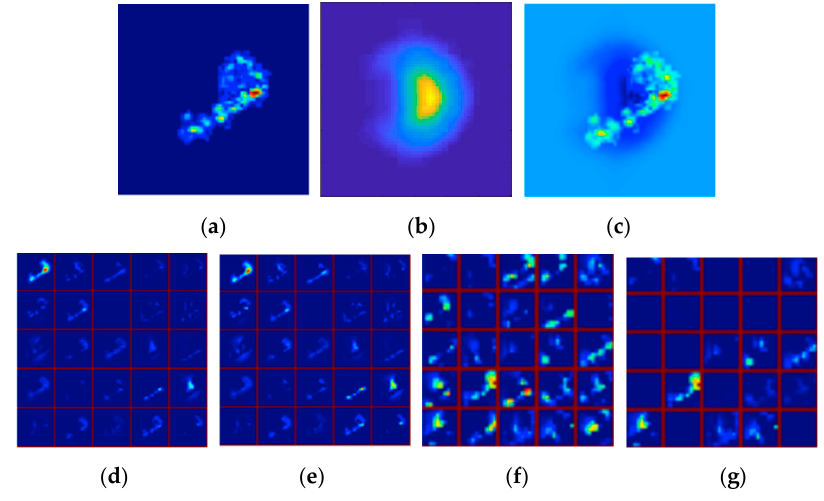
Figure 10. Visualization of feature maps in the ESENet. ( a ) input image; ( b ) mean of training samples; ( c ) input image with the mean of the training samples removed; ( d ) feature maps of conv2; ( e ) feature maps of conv2 after passing through the SE module; ( f ) feature maps of conv3; and, ( g ) feature maps of conv3 after passing through the enhanced-SE module.